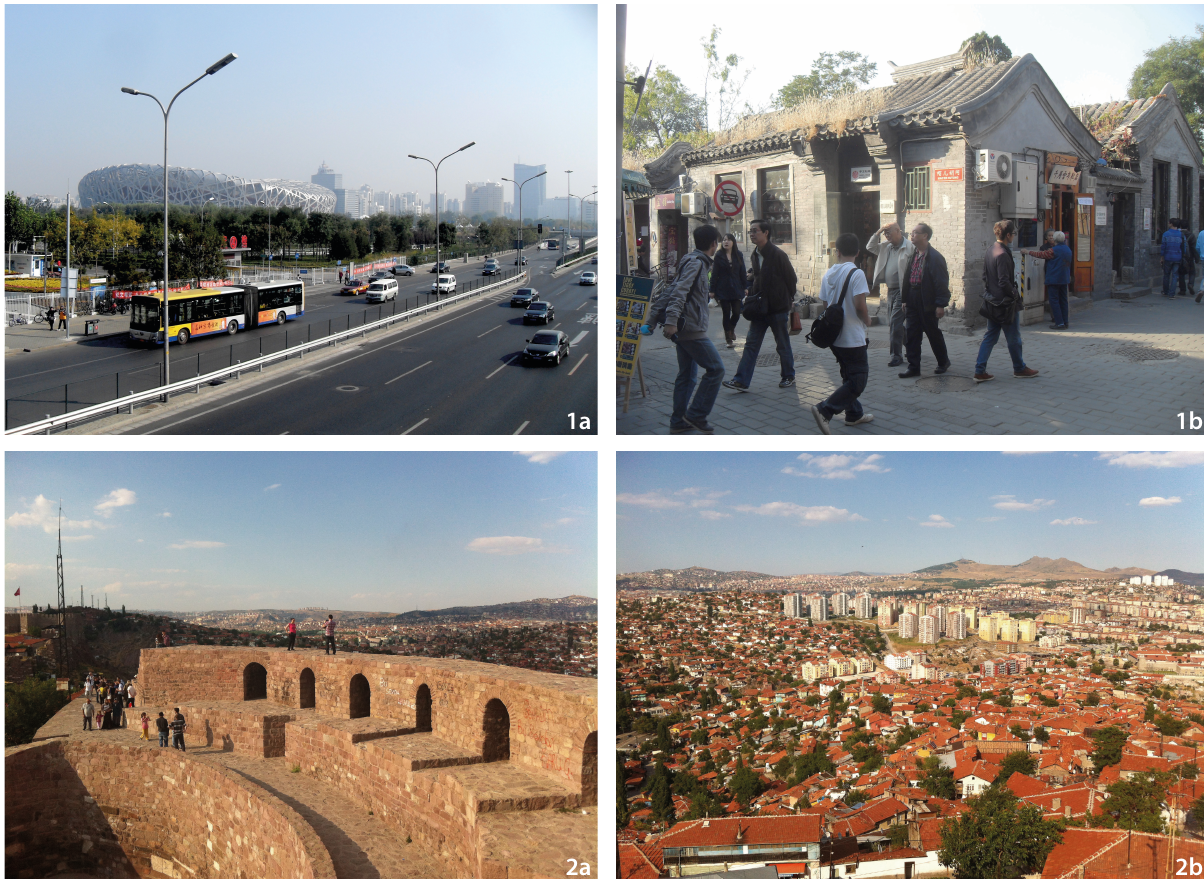
Figure 1a and 1b Beijing, People’s Republic of China. The Olympic Games area and the remained traditional hutongs now mainly transformed into commercial streets (Source: the author). Figure 2a and 2b Ankara, Turkey, 2012. The Hisar fortress of Ulus district and the surrounding view on modern residential com- pounds (Source: the